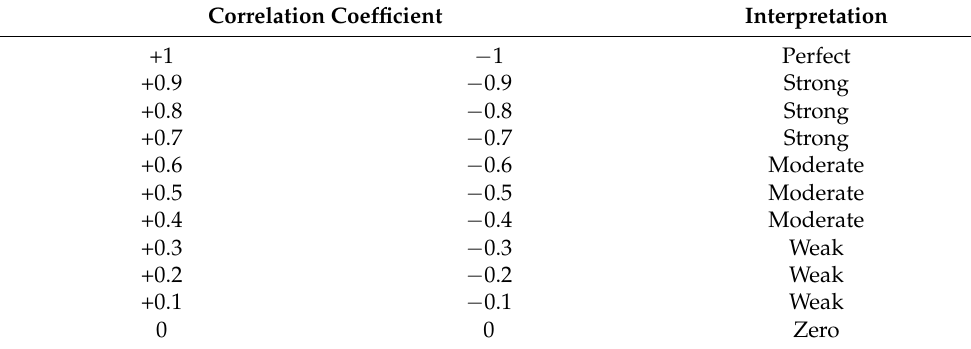
Table 1. Spearman correlation coefficient’s interpretation. Correlation